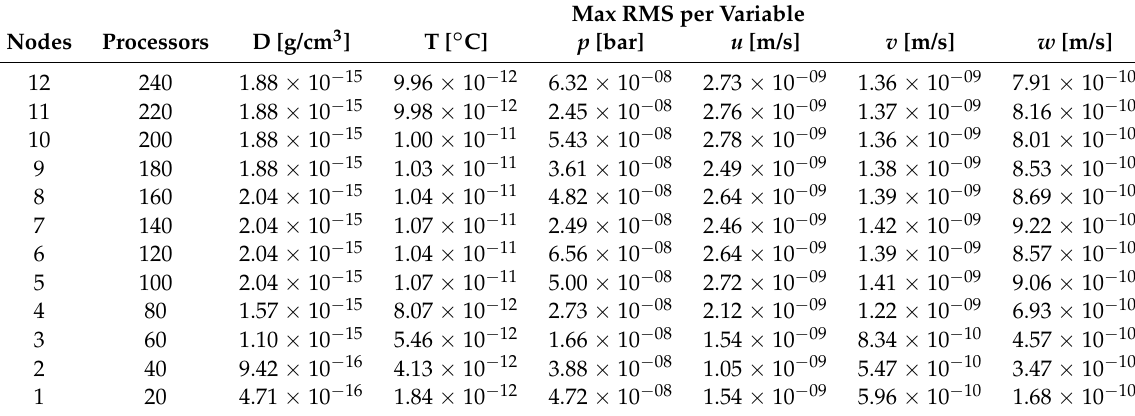
Table A2. Max RMS per variable when comparing Parallel GCCOM Model outputs from 20 to 240 processors across 12 nodes vs. Parallel GCCOM output in a single